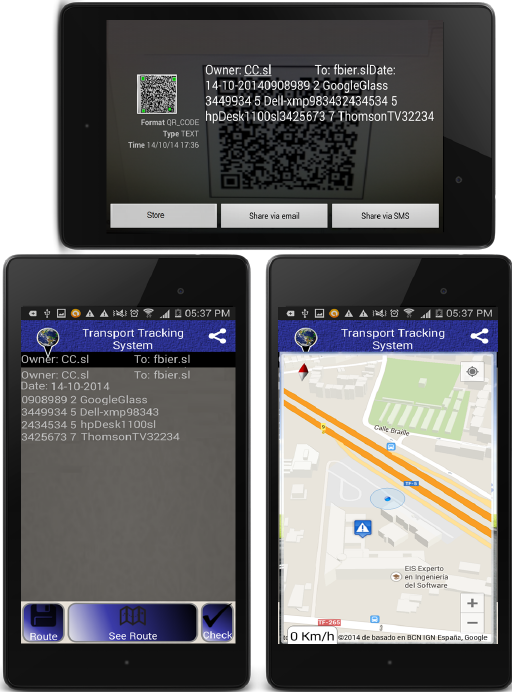
Figure 3. Android implementation of the supply chain